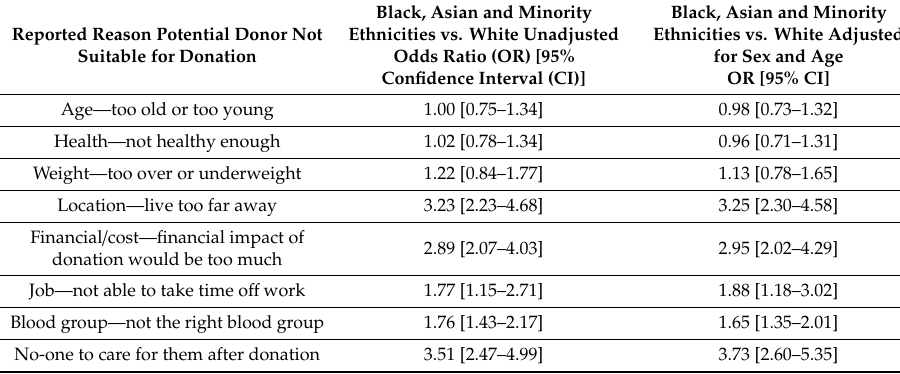
Table 3. Multivariable logistic regression analysis comparing reasons potential donor unsuitability between White and Black, Asian and minority ethnic participants a .